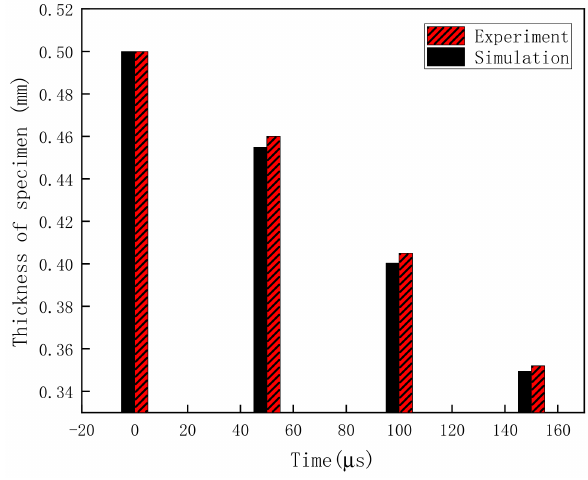
Figure 14. Comparison between specimen thicknesses in test and simulation.